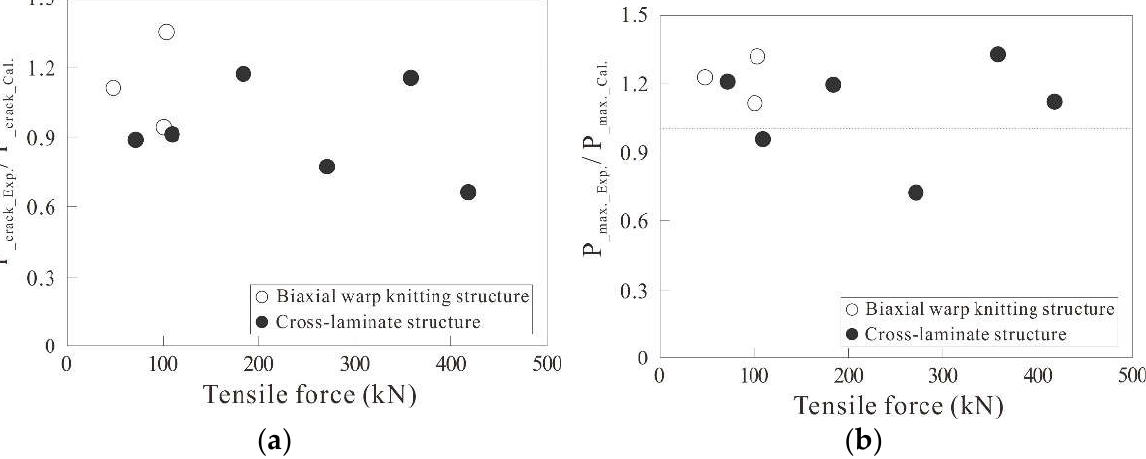
Figure 16. Strength ratio of experimental and calculation results according to carbon grid tensile force: ( a ) crack; and ( b ) flexural